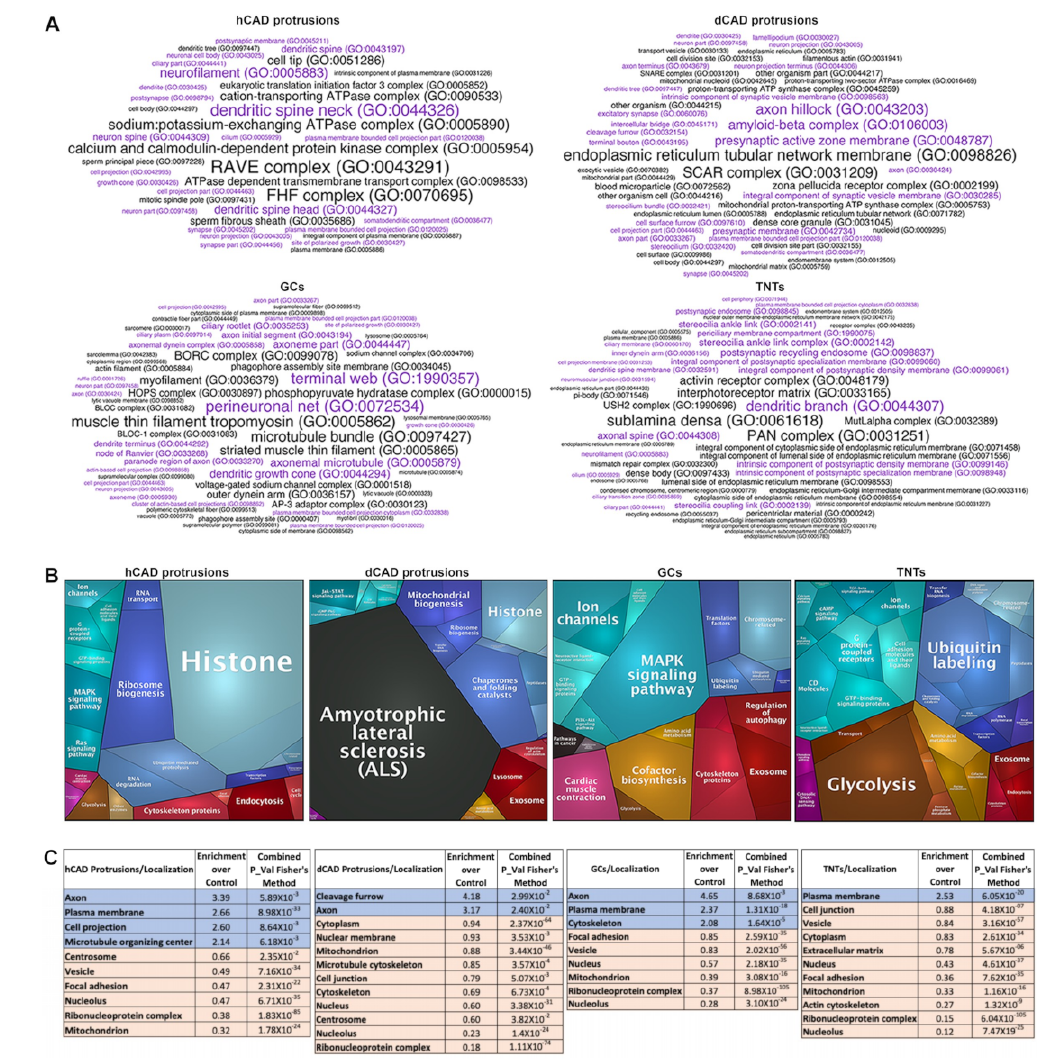
Figure 7. Microproteomics Analysis of cellular protrusions using annotations. ( A ) Functional categories from Gene Ontology enrichment analyses (FIDEA Enrichment word clouds) using the subtractive approach are shown for hCAD protrusions, dCAD protrusions, GCs and TNTs. GO Terms related to protrusions (Figure S5H) are shown in violet. A clear enrichment of GO terms related to